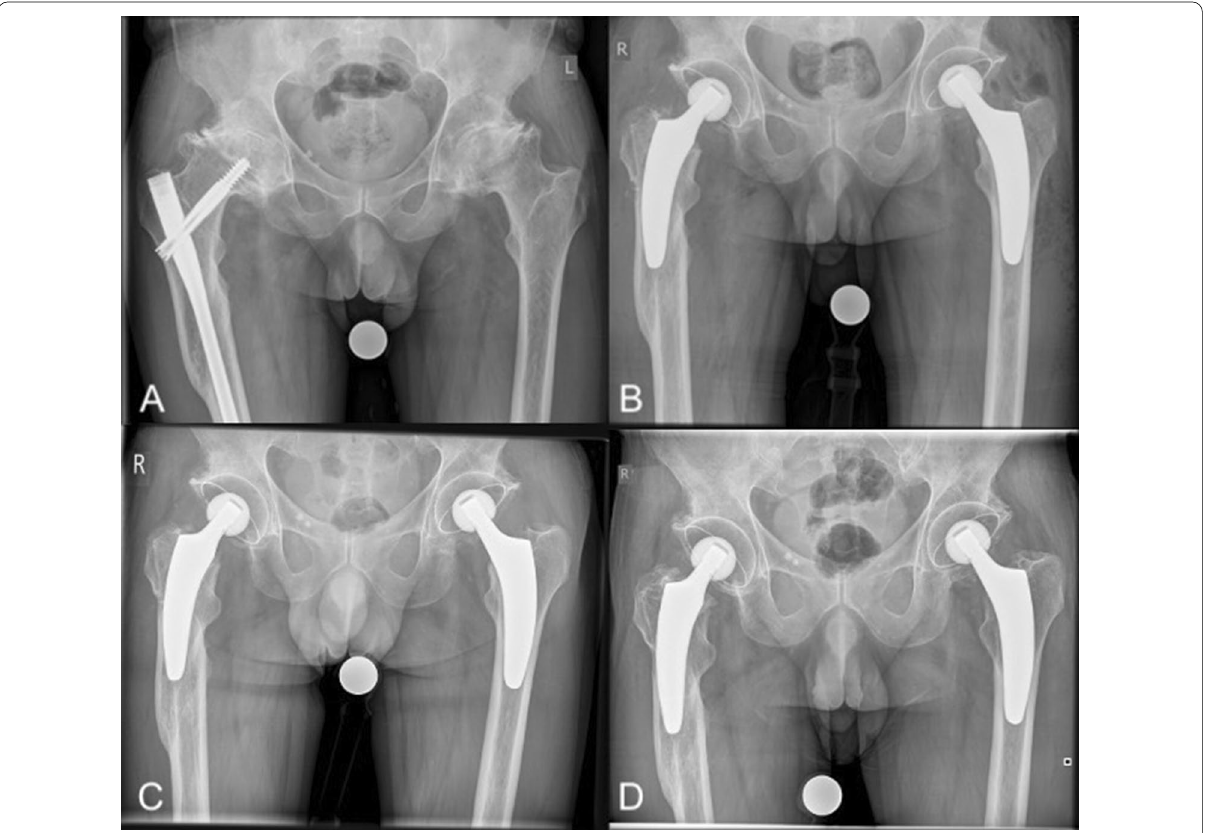
Fig. 2 Radiographs of a 57-year-old male patient with secondary osteoarthritis ( right ) and primary osteoarthritis ( left ): A preoperative; B postoperative following one-stage bilateral THA; C 6-week follow-up; D 24-month follow-up (no signs of